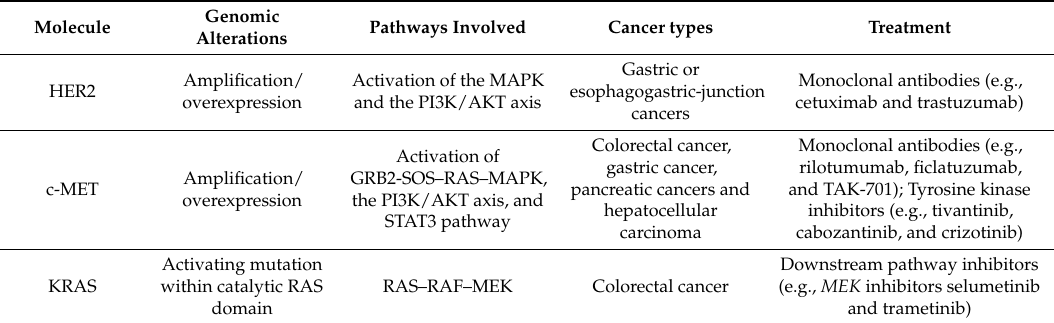
Table 2. Characteristics of HER2, c-Met, and KRAS expression in gastrointestinal (GI) cancers.